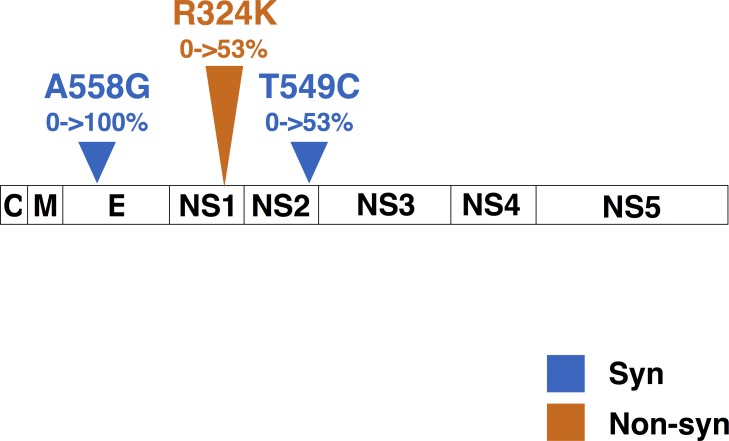
High frequency de-novo variants across the CDS associated with clade A to G replacement.Consensus CDS comparison of Clade A vs. G samples. Nonsynonymous mutation R324K in NS1 and synonymous mutation T549C in NS2A undetected in Clade A, observed in 10/9 samples composing Clade G.